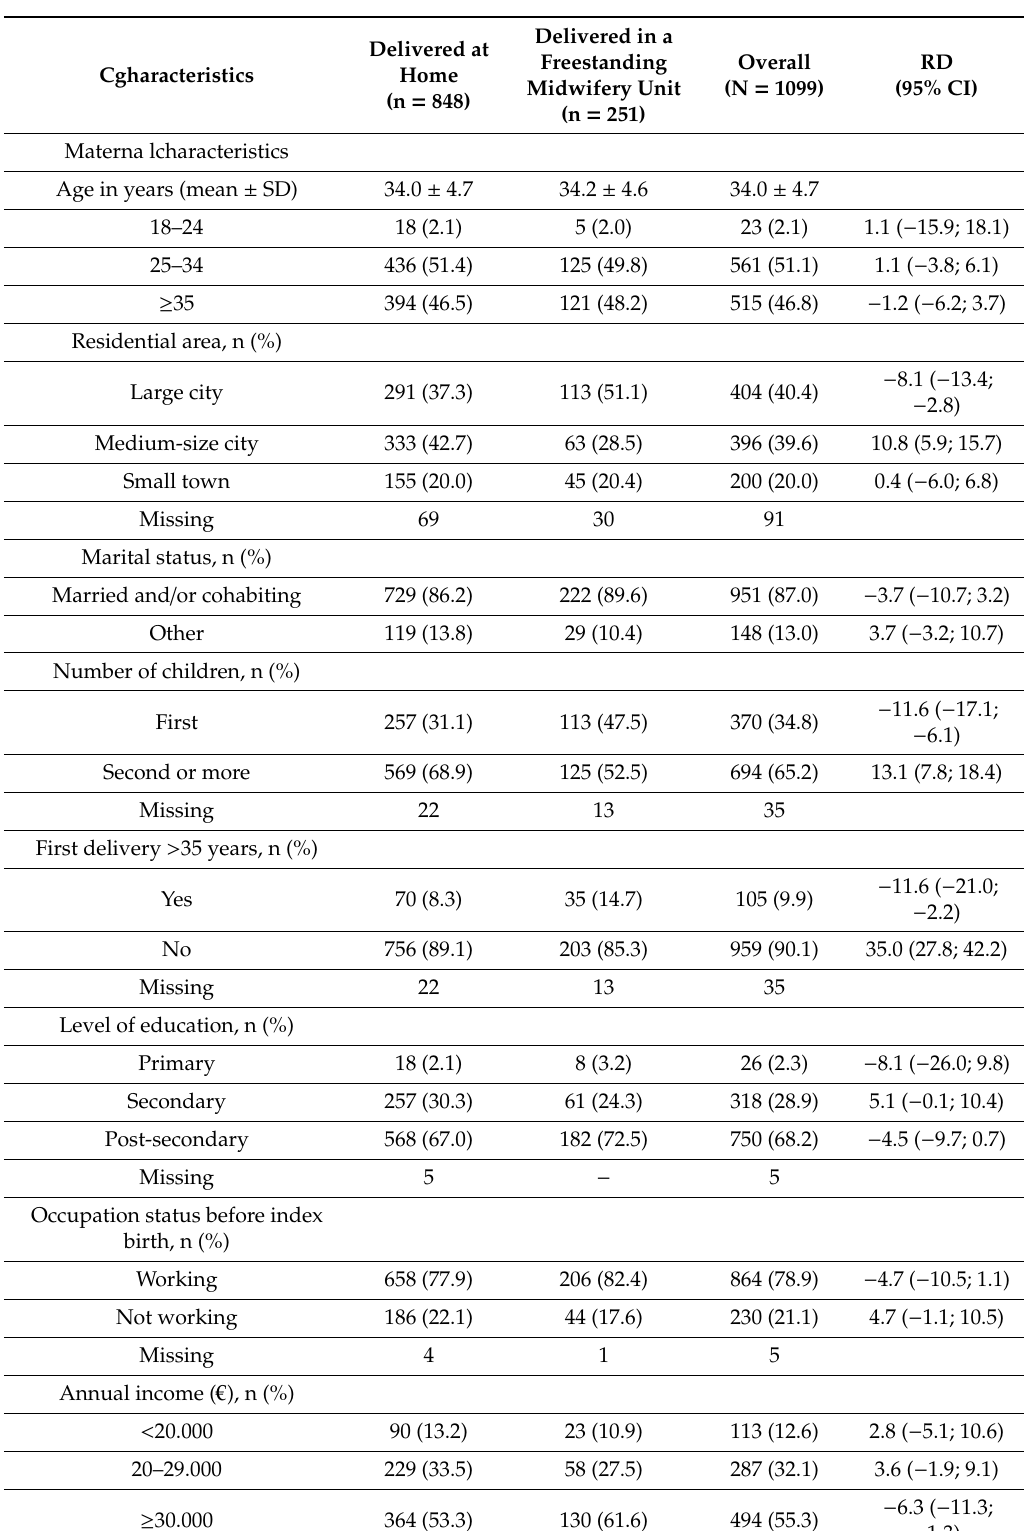
Table A1. Maternal and partner characteristics by birth at home or in a midwifery unit. Delivered Cgharacteristics